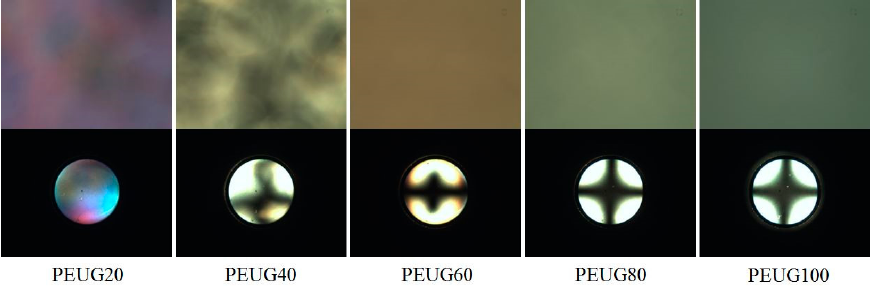
Figure 5. Polarized optical microscopy (POM) images of the LC cells made from PEUG#.